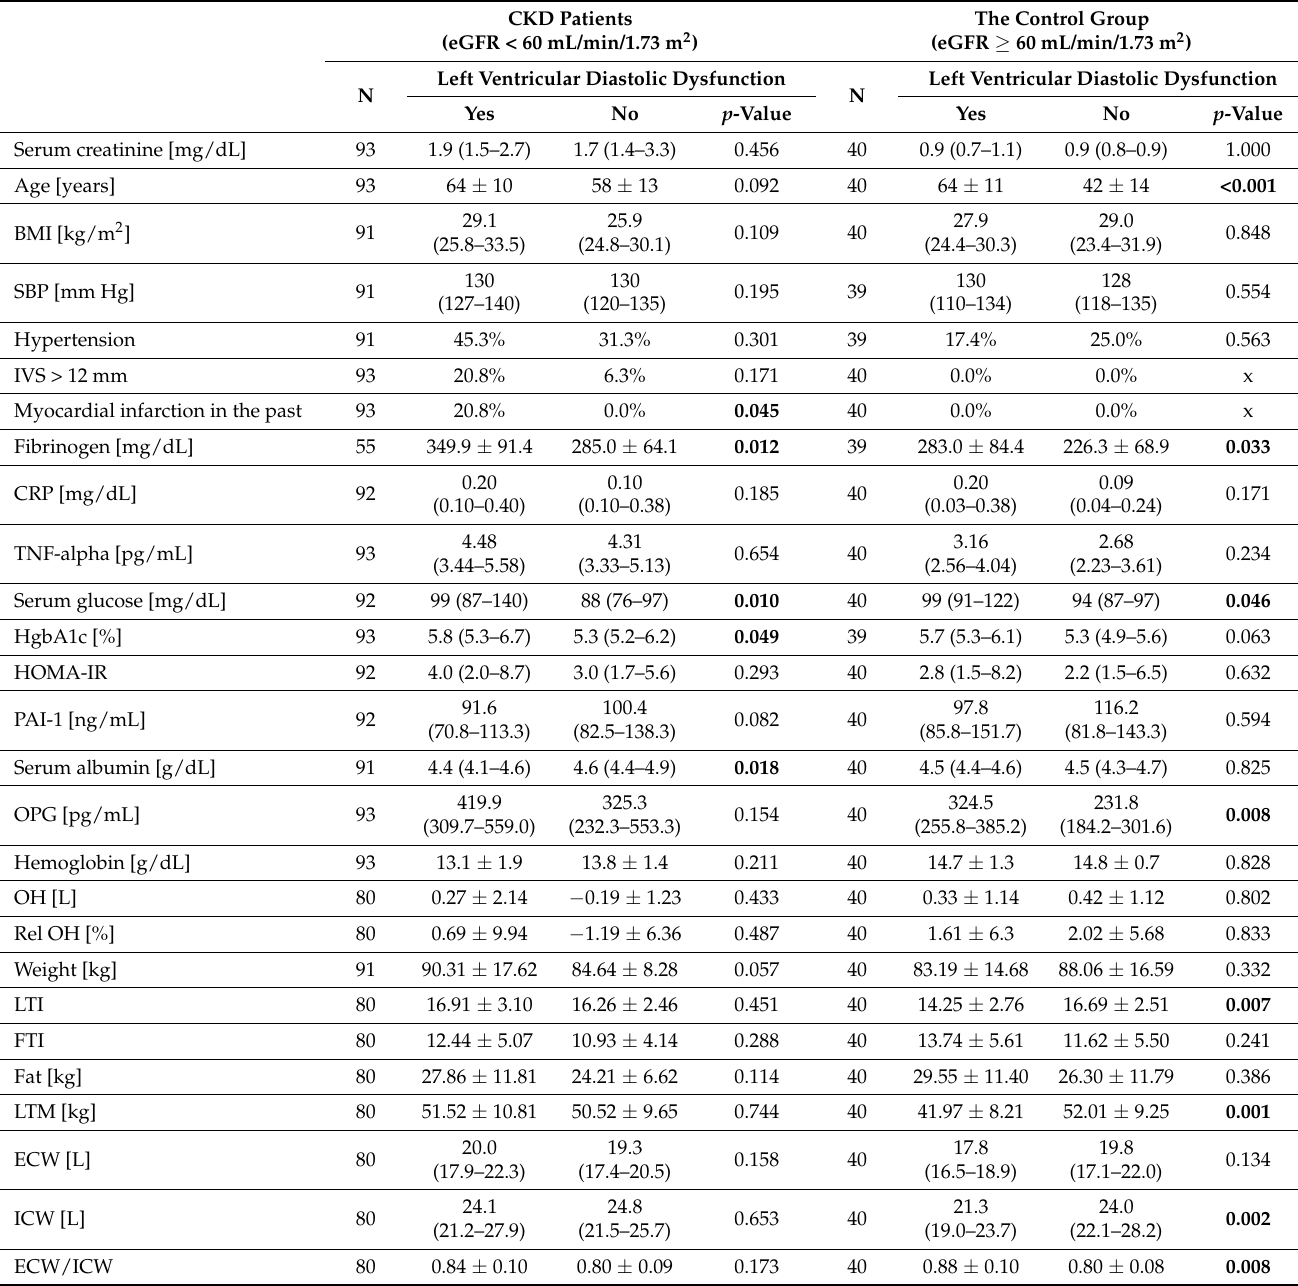
Table 2. LVDD and metabolic, nutritional and inflammatory parameters in CKD and non-CKD